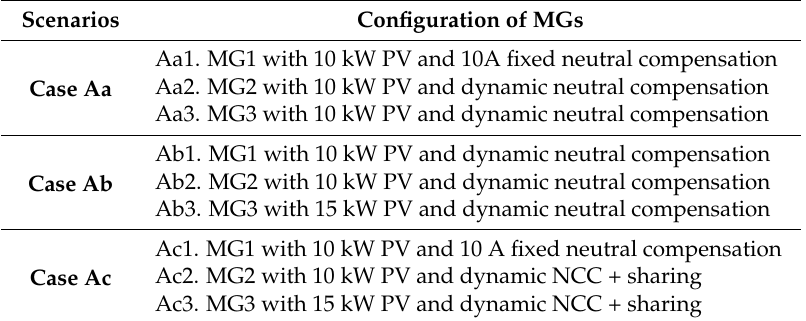
Table 2. Case scenarios for MMG control system performance.